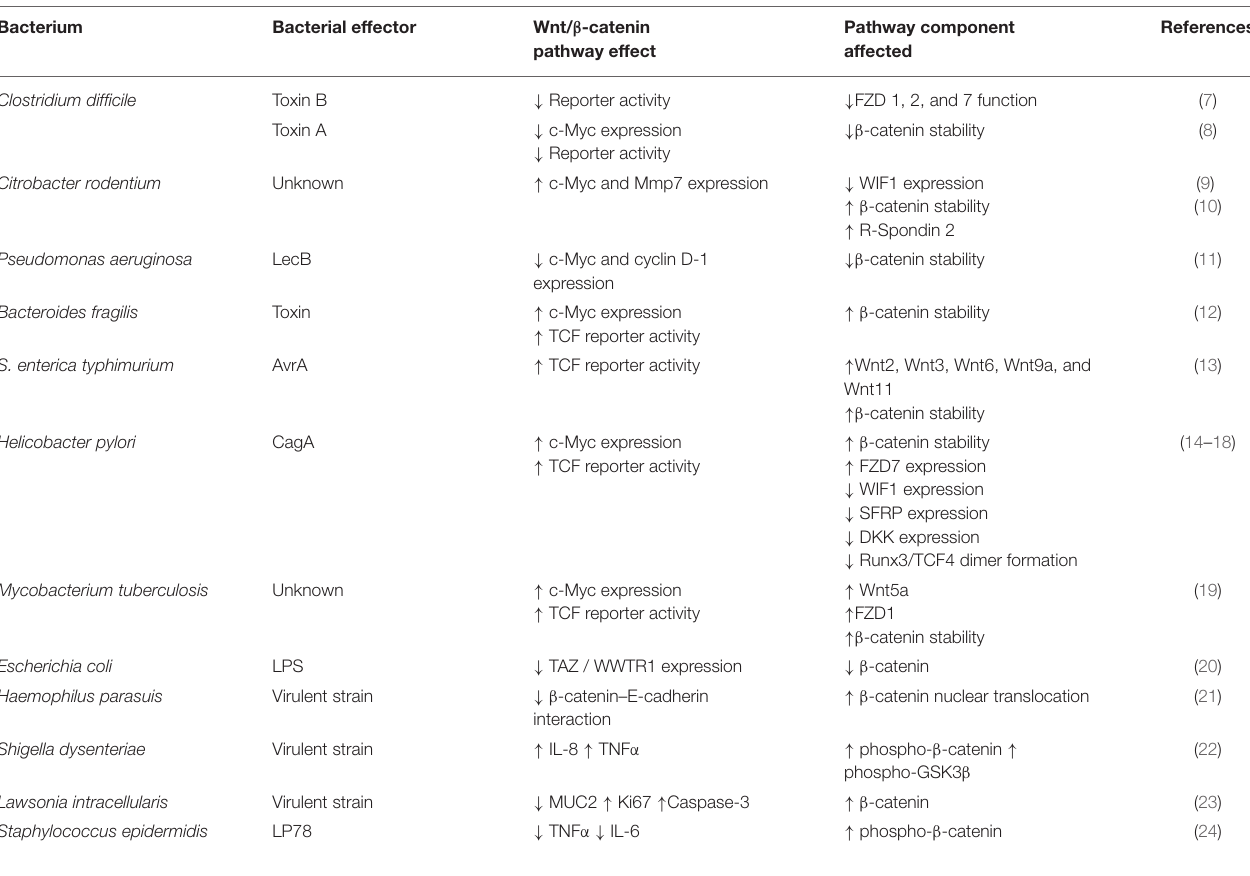
TABLE 1 | Effects of bacterial virulence factors on Wnt/ β -catenin signaling pathway.